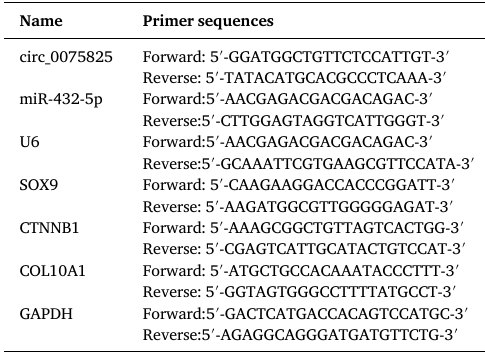
Table 1 Sequences used for